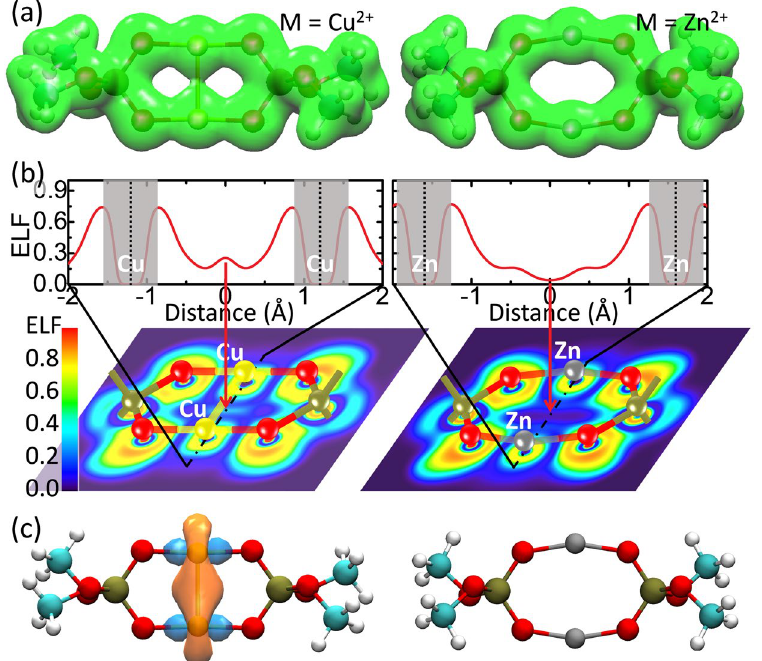
Figure 4. Electron analyses of Cu ions (left column) in State II by comparison with Zn ions (right column). The cyan, brown, red, white, yellow and dark gray balls represent carbon, phosphorus, oxygen, hydrogen, copper and zinc, respectively. ( a ) Electron densities. The green cloud denotes the electron density with an isosurface of 0.04 e/Å 3 . ( b ) Electron localized function (ELF). Upper: One-dimensional ELF along the metal-metal direction. The gray area indicates the region of core electrons, where ELF decays and quickly vanishes because a pseudo potential is employed in DFT calculations. Lower: Two-dimensional ELF. The pattern of ELF is approximately square in the area close to a Cu ion (lower-left) and is a circle in the area close to a Zn ion (lower-right). These suggest that the outermost electrons majorly occupy the 3d orbital for Cu and the 4 s orbital for Zn. ( c ) Natural bond orbital between metal ions. The orange and light blue clouds indicate the orbital with an isosurface of 0.04 e/Å 3 . A metal-metal bond orbital occurs for Cu ions but not for Zn ions. For clarity, water molecules are not